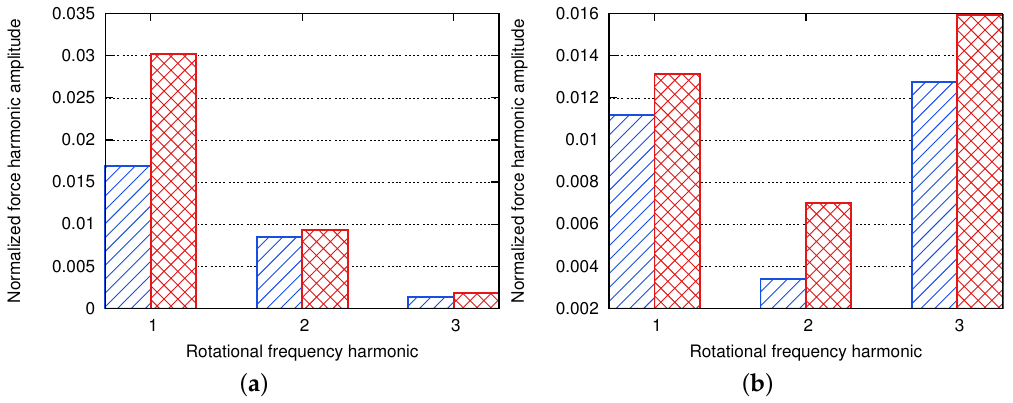
Figure 13. Normalized mean value ( a ) and standard deviation ( b ) of the integrated fan-blade loading at the RF and its harmonics. Axisymmetric air inlet in hatched blue bars and asymmetric air inlet in crosshatched red